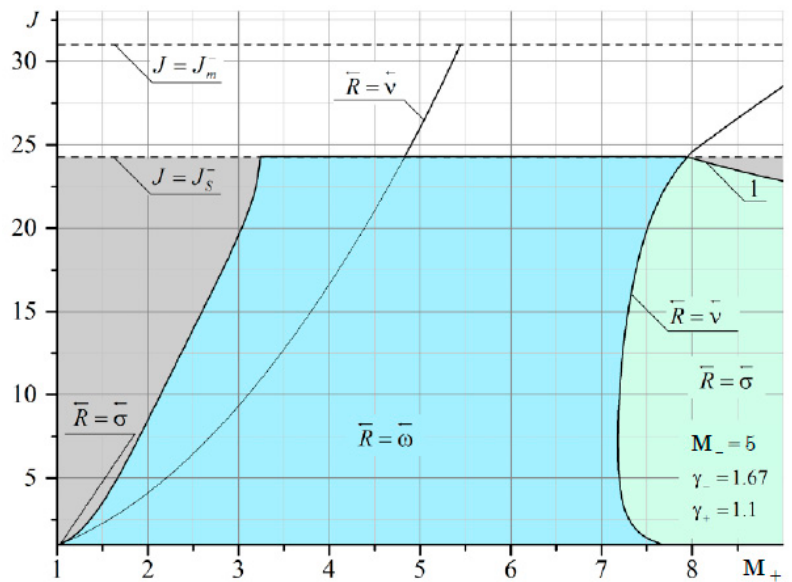
Figure A12. Domains of existence of reflected discontinuities for refraction from a monatomic gas into a gas consisting of combustion products. The Mach number of the flow from which the shock comes is M – = 5. The domains of existence of reflected discontinuities for refraction from a diatomic gas into a gas consisting of combustion products at the Mach number of the flow M – = 2 are shown in Figure A13.